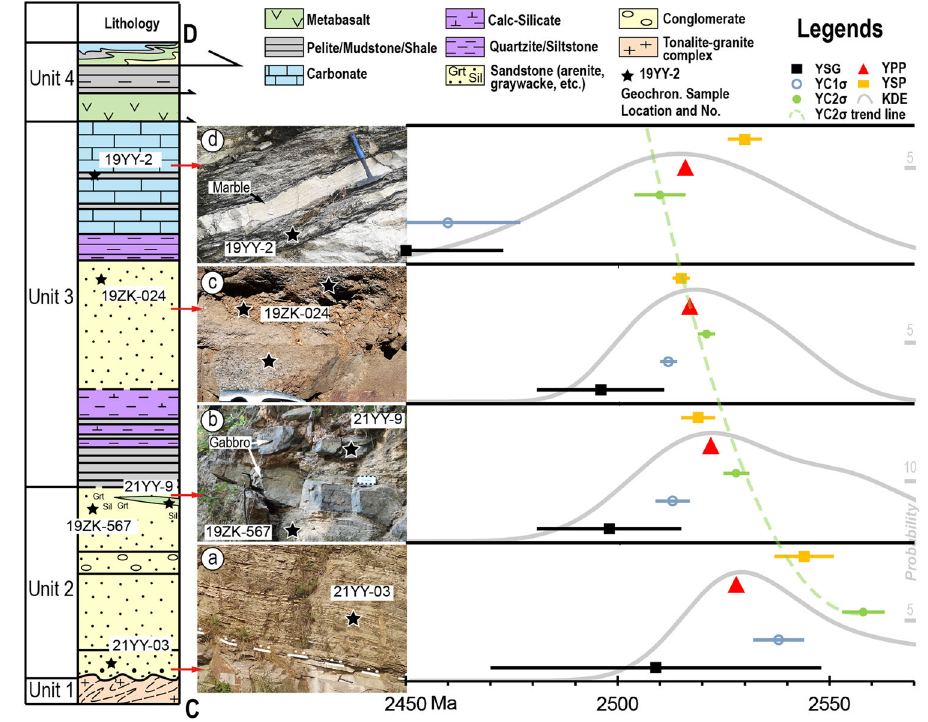
Fig.2|Tectono-stratigraphiccolumnandmaximumdepositionalage.a – d Field picturesofrockunitssampledforgeochronologyoftransectC-D.Samplelocations are shown on the stratigraphic column, and on the accompanying photos. Right side shows plots of age calculations from detrital zircon data, and trend line (not quanti fi ed).In( a )dashedlinewithdotsshowstheunconformitysurface,blackstars in all photos show zircon sample locations. b Amphibolitic meta-gabbroic sill